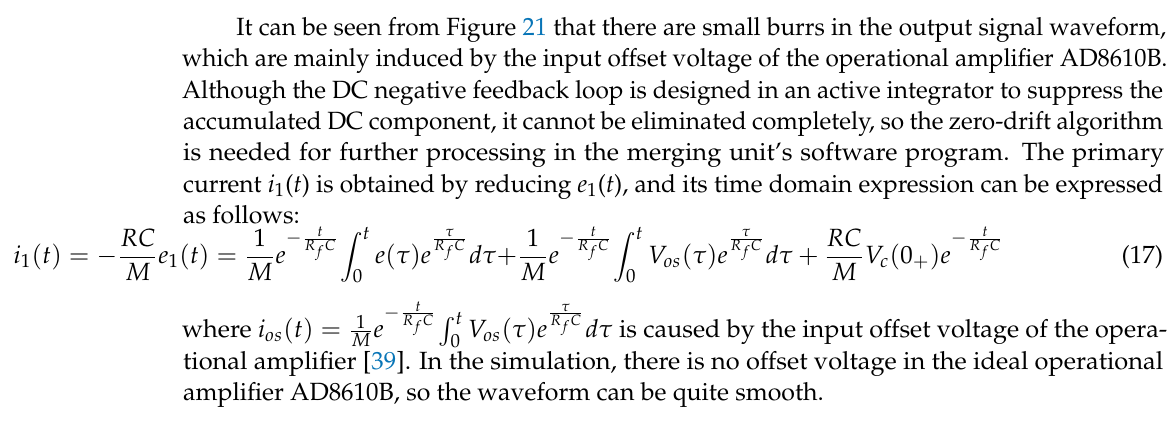
Figure 21. Typical wave shapes of i PF , U l , VFTC and its expansion. ( a ) i PF waveforms; ( b ) U l waveforms; ( c ) VFTC waveforms; ( d ) the expansion of VFTC